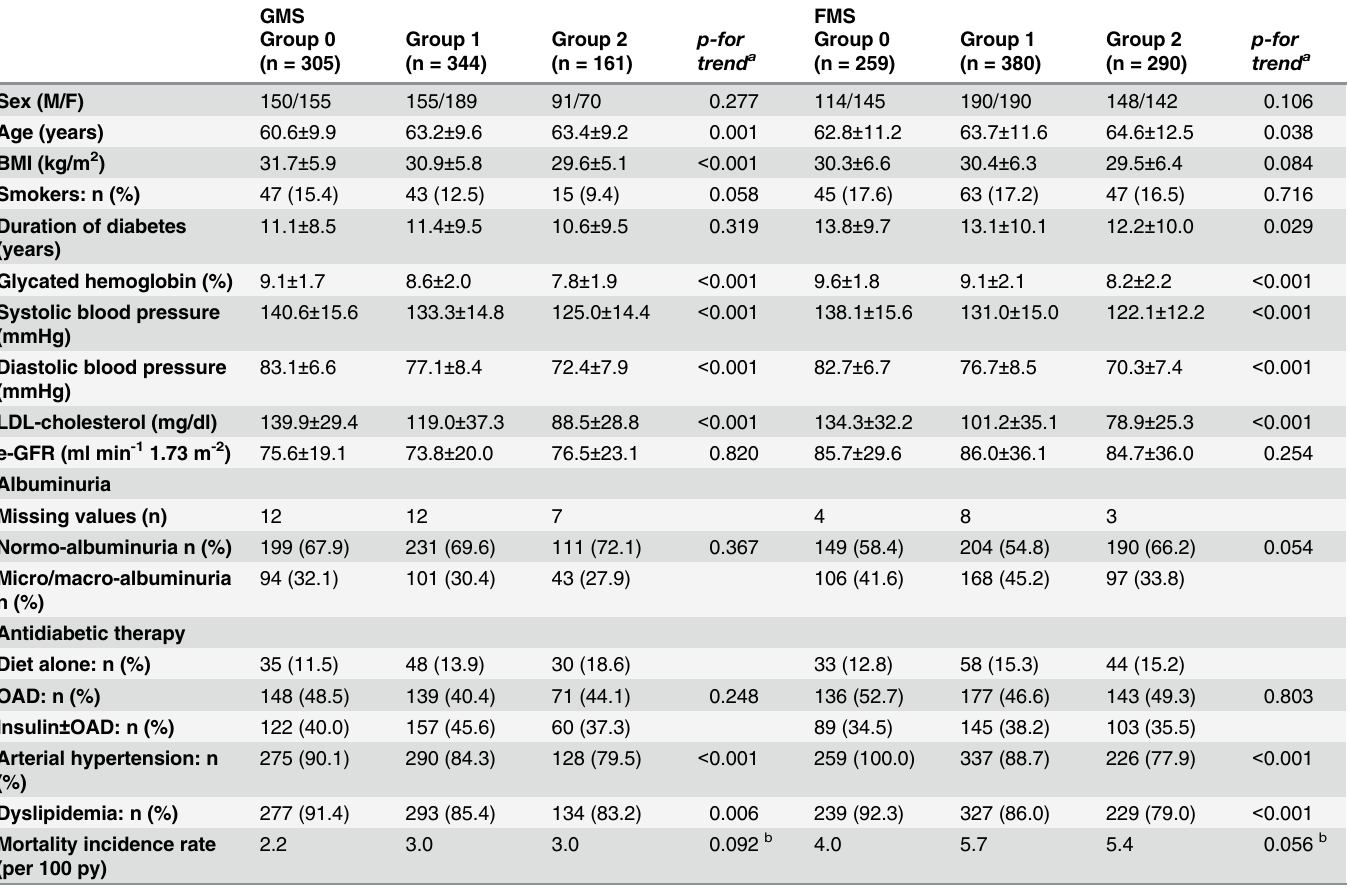
Table 2. Baseline clinical features of 1739 patients with type 2 diabetes according to categories of target